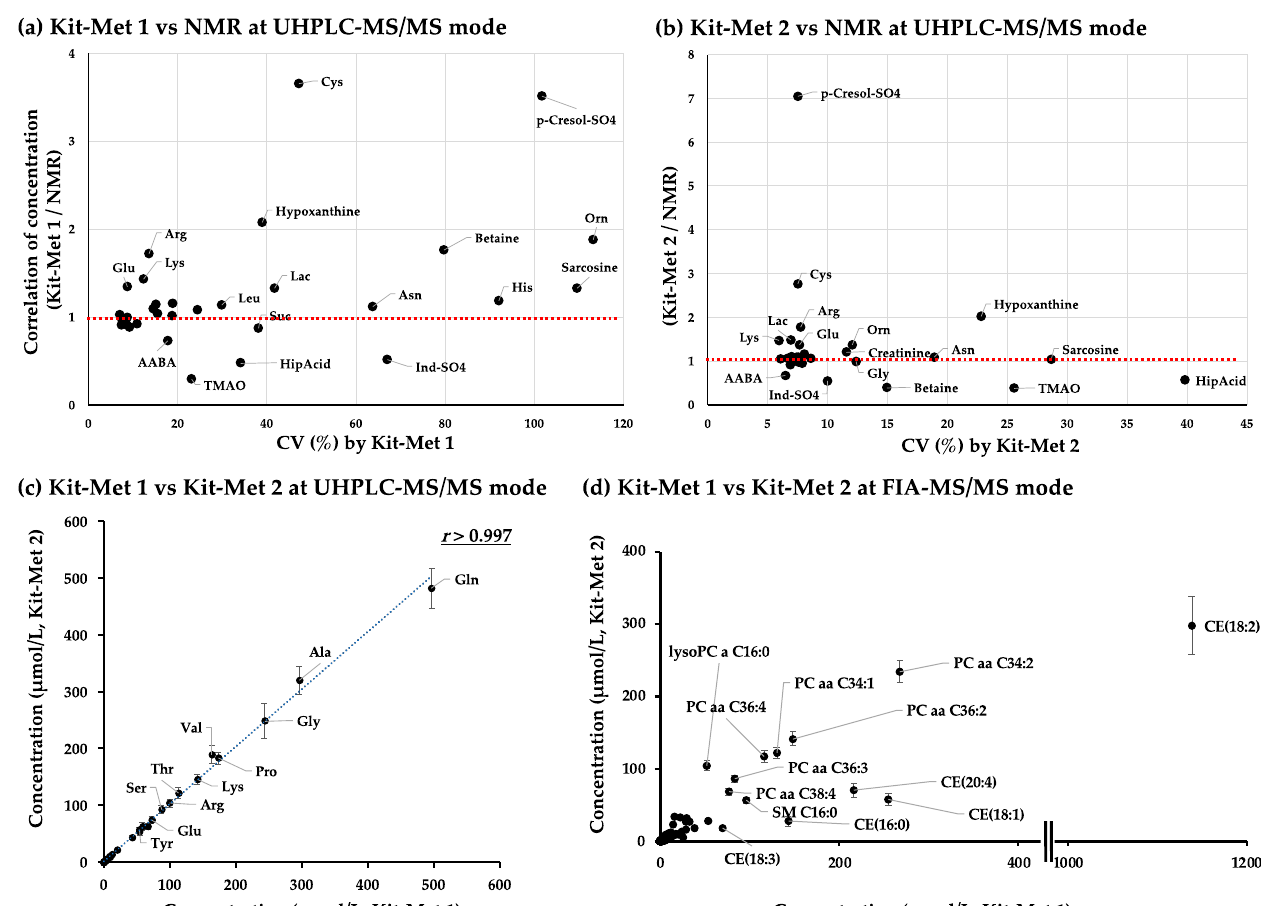
Figure 3. Correlation plots of metabolites detected in the NIST plasma samples by NMR, Kit-Met 1, and Kit-Met 2. ( a ) Plot of the correlation of the concentrations of 31 metabolites detected by NMR and Kit-Met 1 with CV (%) in UHPLC-MS/MS mode; ( b ) plot of the correlation of the concentrations of 31 metabolites detected by NMR and Kit-Met 2 with CV (%) in UHPLC-MS/MS mode; ( c ) plot of the concentrations ( μ mol/L) of 32 metabolites detected by Kit-Met 1 and Kit-Met 2 in UHPLC-MS/MS mode, where the standard deviation of each metabolite is shown for Kit-Met 2; and ( d ) plot of 273 metabolites detected by Kit-Met 1 and Kit-Met 2 in FIA-MS/MS mode. Metabolites were selected with a CV < 30% from 33 NIST plasma samples detected with Kit-Met 1 and Kit-Met 2. The dotted line shows the linear regression of each plot. The correlation of concentration was calculated by the ratio between the mean values of 80 or 33 NIST plasma samples detected by Kit-Met 1 or Kit-Met 2 and the mean values of 5 NIST plasma samples detected by NMR. The red dotted line shows a ratio of 1.0.